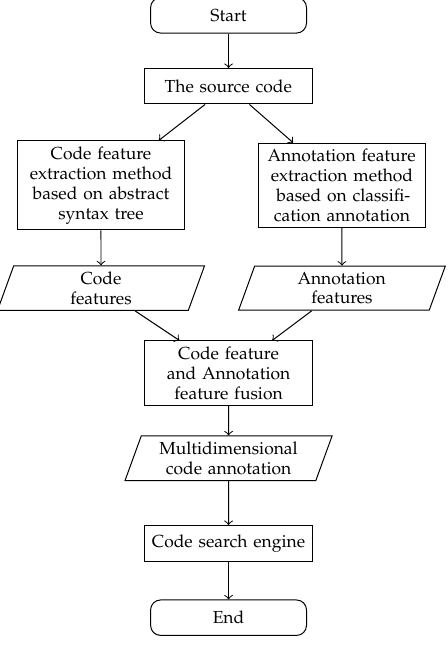
Figure 2. The overall framework of our approach.